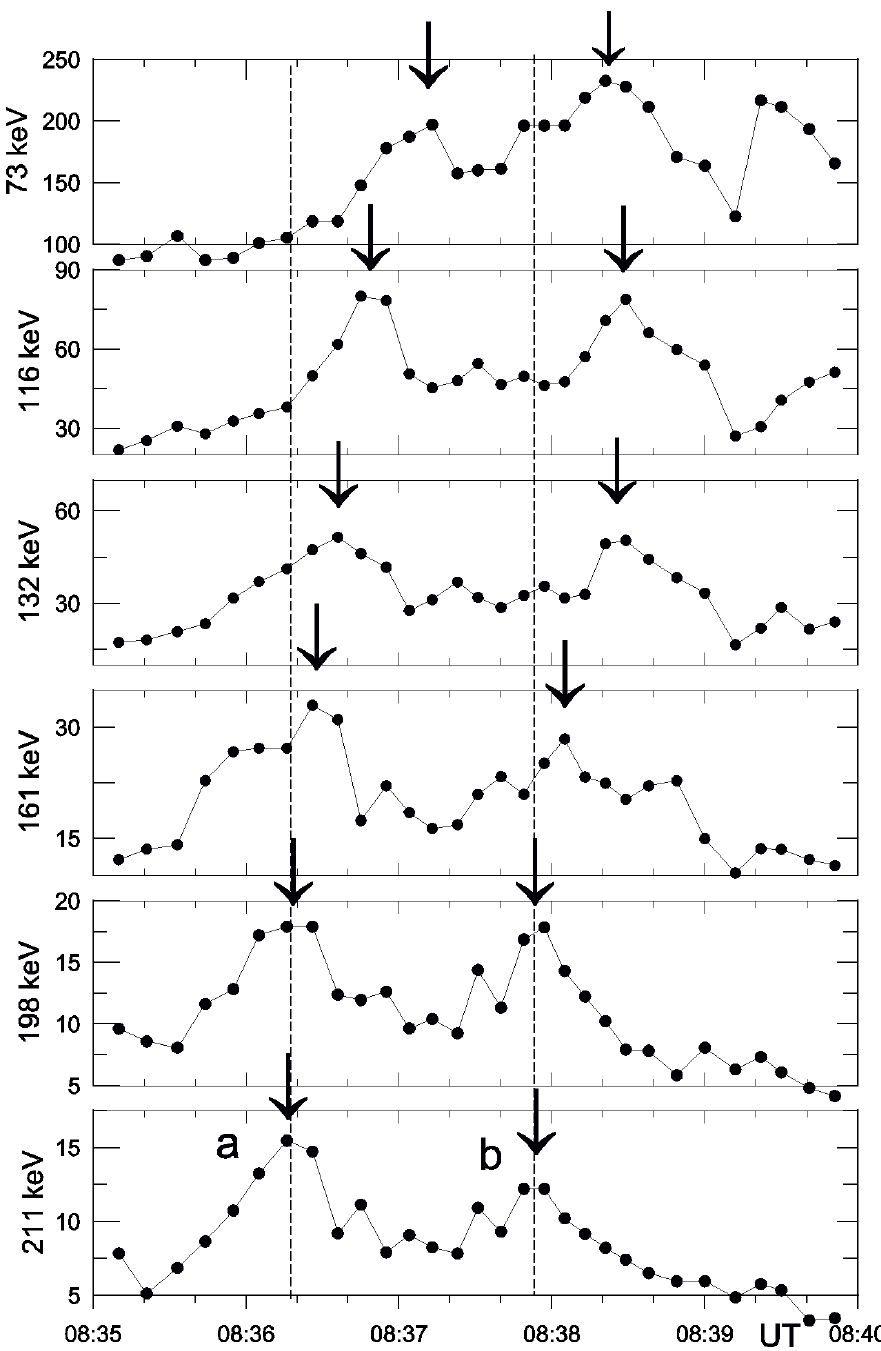
Fig. 5. Similar format as in Fig. 1, but for two ion dispersive flux increases.